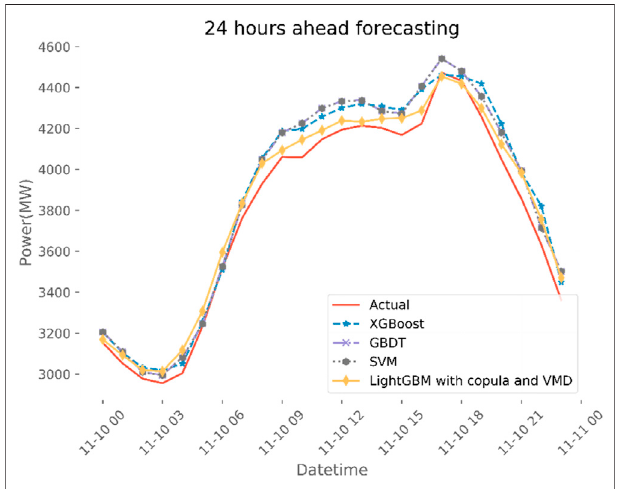
FIGURE 5 | Comparison of forecasting results between the proposed scheme and traditional